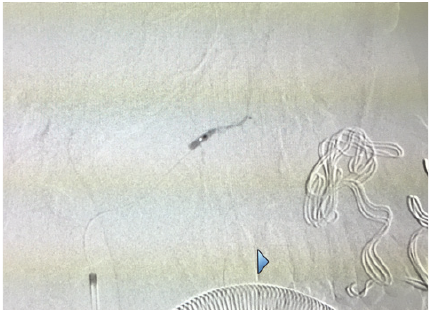
Figure 4: A mixture of 50% of acrylic-glue (Glubran 2) and Lipiodol ultrafluid was injected up to the complete occlusion of the lesion.